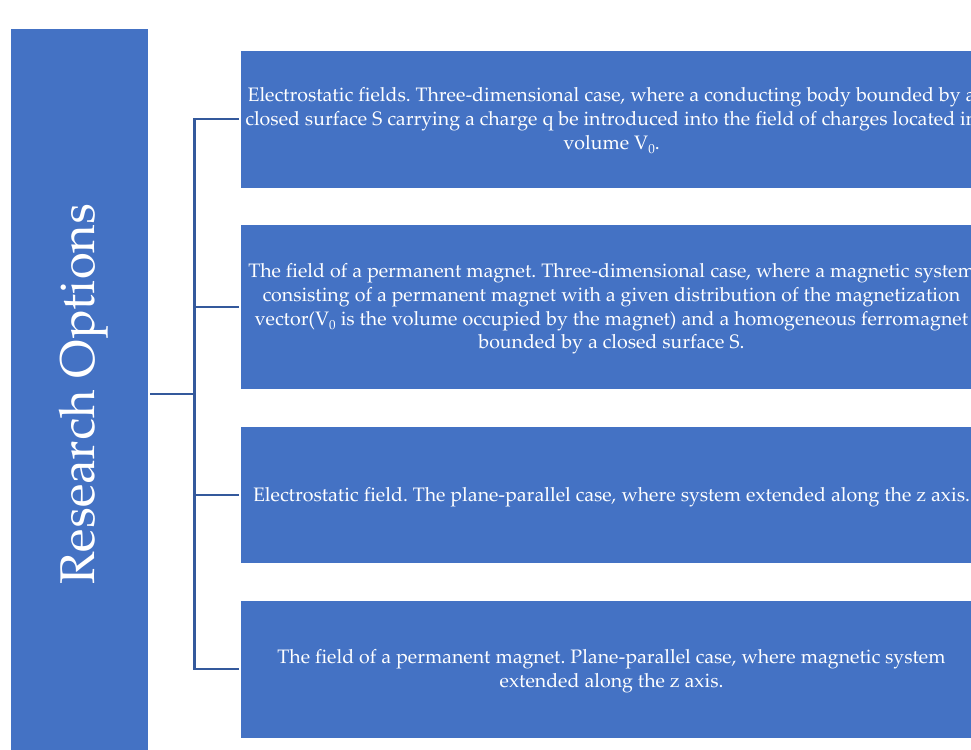
Figure 2. Options considered in this study.